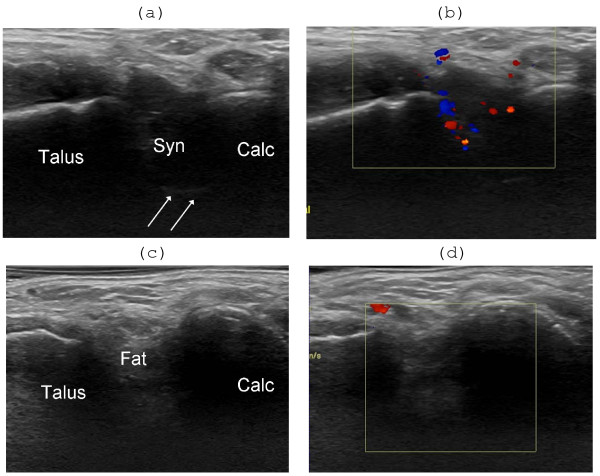
Effect of US-guided steroid injection in the antero-lateral recess of the posterior subtalar joint . Lateral oblique longitudinal scanning planes. (A) Before injection there is an enlarged hypoechoic antero-lateral recess (Syn), with distinct deep margins (arrows), bulging into the hyperechoic fat of the tarsal sinus between talus and calcaneus (Calc), and (B) synovial hyperemia at color Doppler examination. (C) One week after injection the recess is not visualized (D) and there is complete regression of synovial hyperemia.